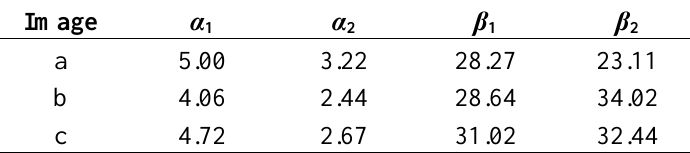
Table 5. Estimated shape and scale parameters